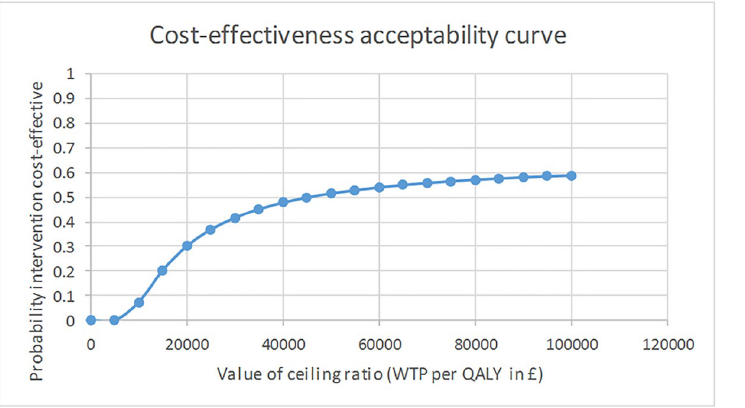
Fig 2. Cost Effectiveness Acceptability